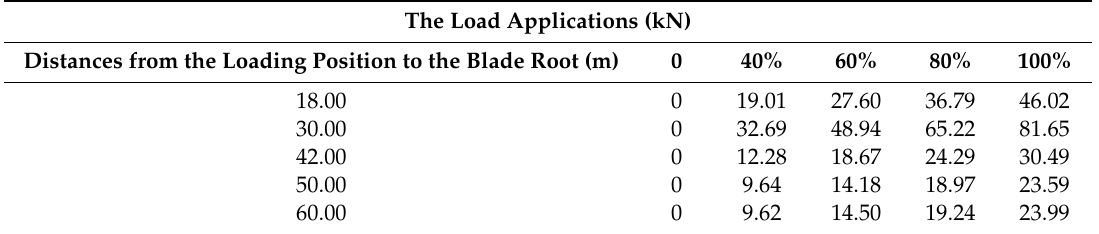
Table 4. The applied load of each stage when loaded on edgewise−.